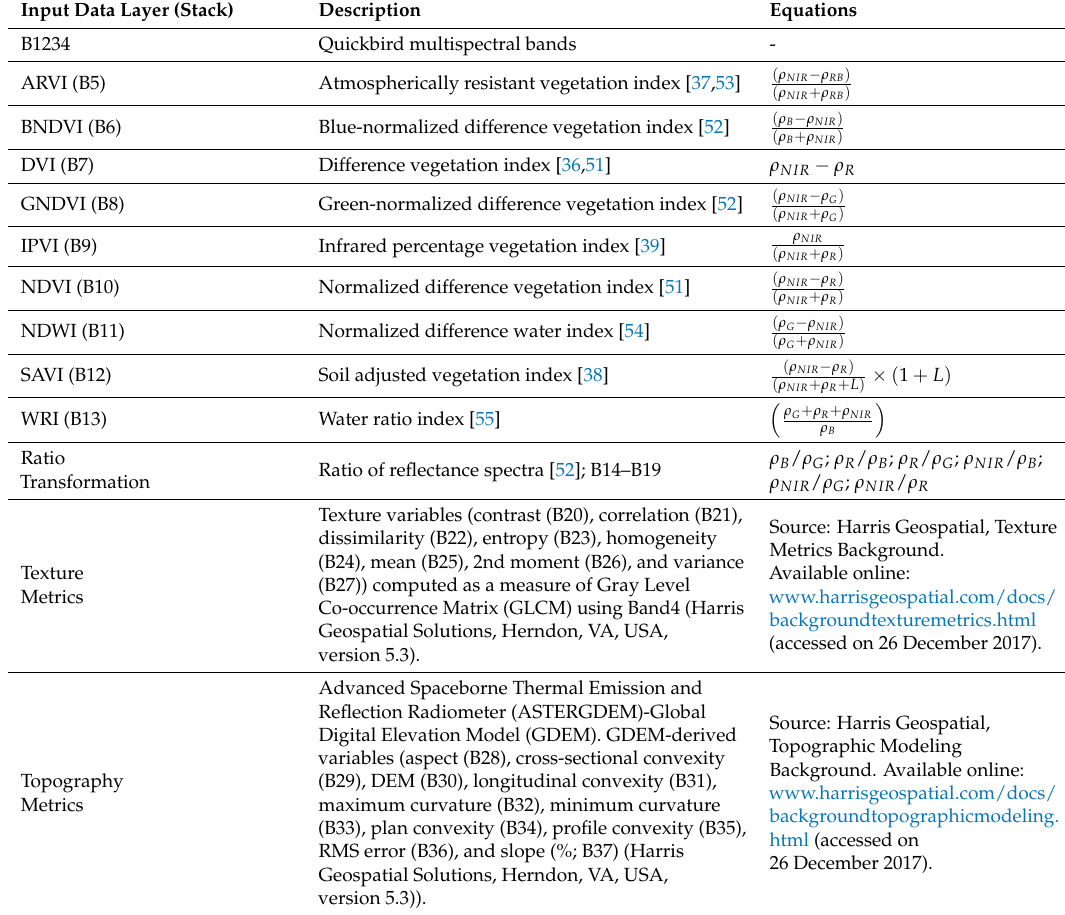
Table 1. Description of the input predictor variables used in this study (B1–B4 are Quickbird multispectral bands, while B5–B37 are identifications assigned to the derived spatial and spectral